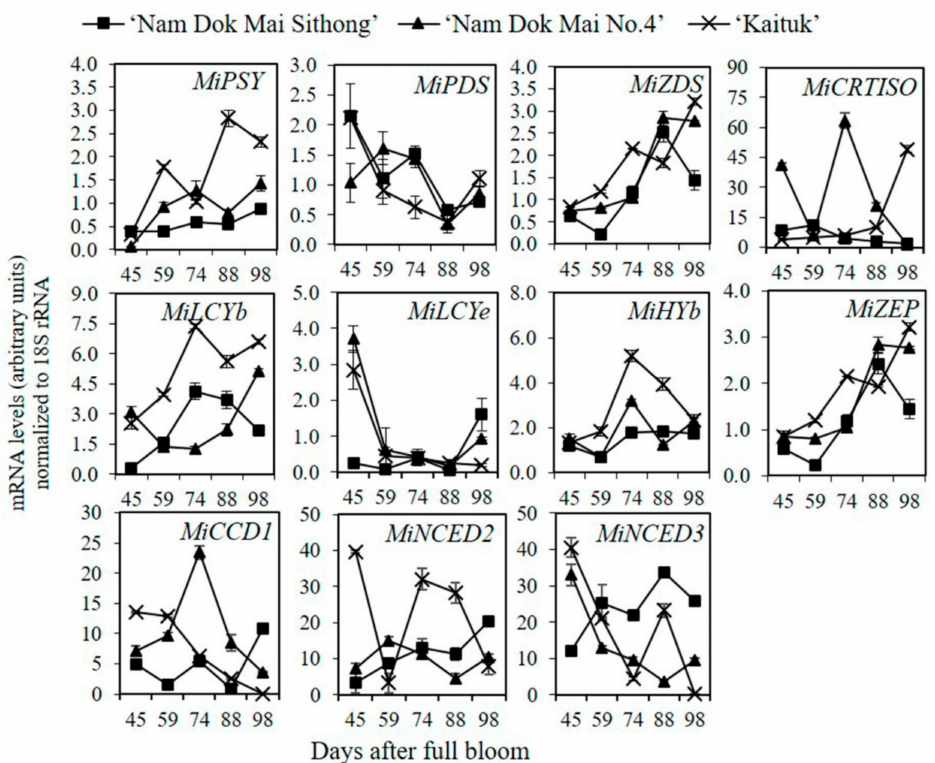
Figure 7. The expression of genes involved in carotenoid metabolism in peel of mango fruit cv. ‘Nam Dok Mai Sithong’, ‘Nam Dok Mai No. 4’ and ‘Kaituk’ during fruit development (45–88 days) and full ripening stage (98 days). The vertical bars represent the means with SE for three